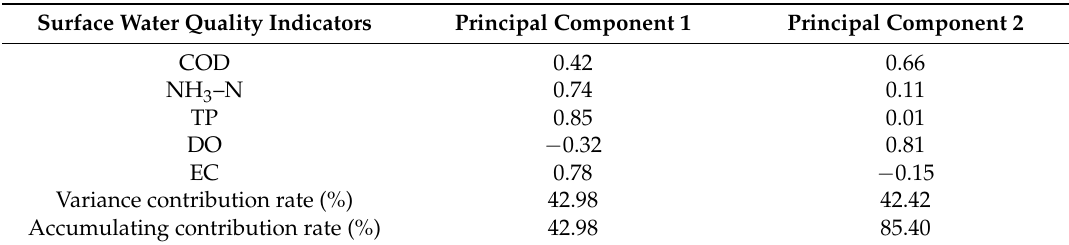
Table 2. The capacity and variance contribution rate of the principal components.